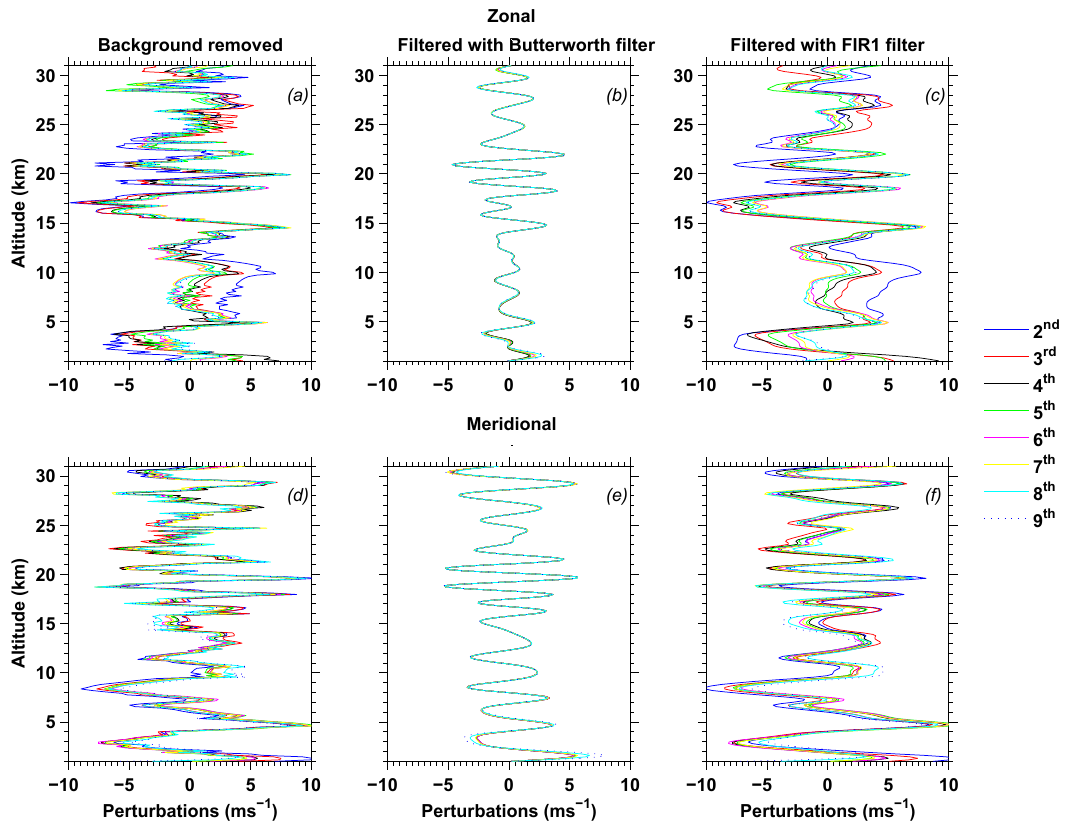
Figure 6. (a, b, c) Vertical profiles of zonal wind fluctuations (ms − 1 ) after approximating the backgrounds with different order (second– ninth) polynomials (a) and filtering height-wise with a Butterworth filter (b) and FIR1 filter (c) . (d, e, f) Same as upper panel but for meridional wind